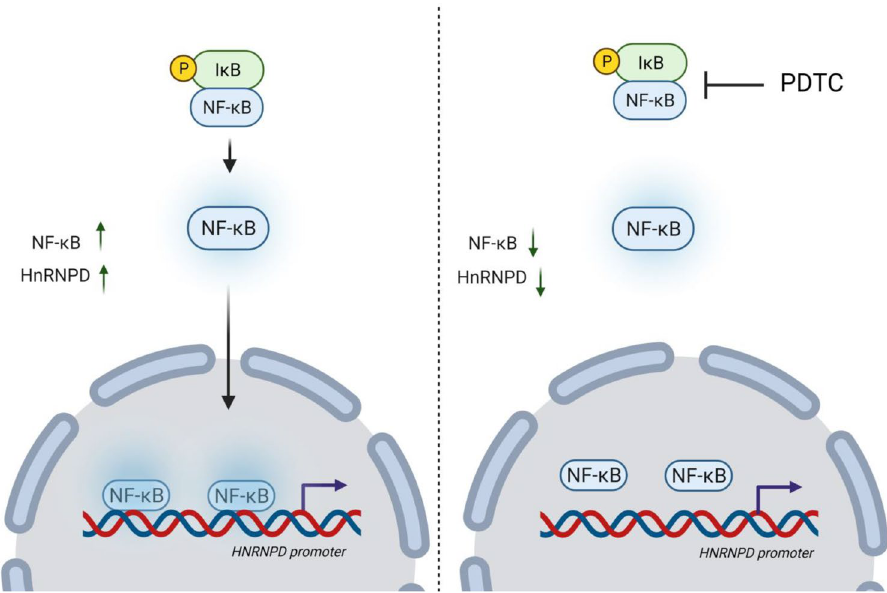
Figure 8. A schematic diagram of NFκB (RelA)-hnRNPD axis in oral cancer. Transcription factor NFκB (Rel A) binds to its binding motifs in hnRNPD promoter region and mediates its transcriptional upregulation in oral cancer cells. Inhibition of NFκB by PDTC leads to decrease in hnRNPD protein and transcript levels by inhibition of NFκB (RelA)-hnRNPD axis in oral cancer (image created with